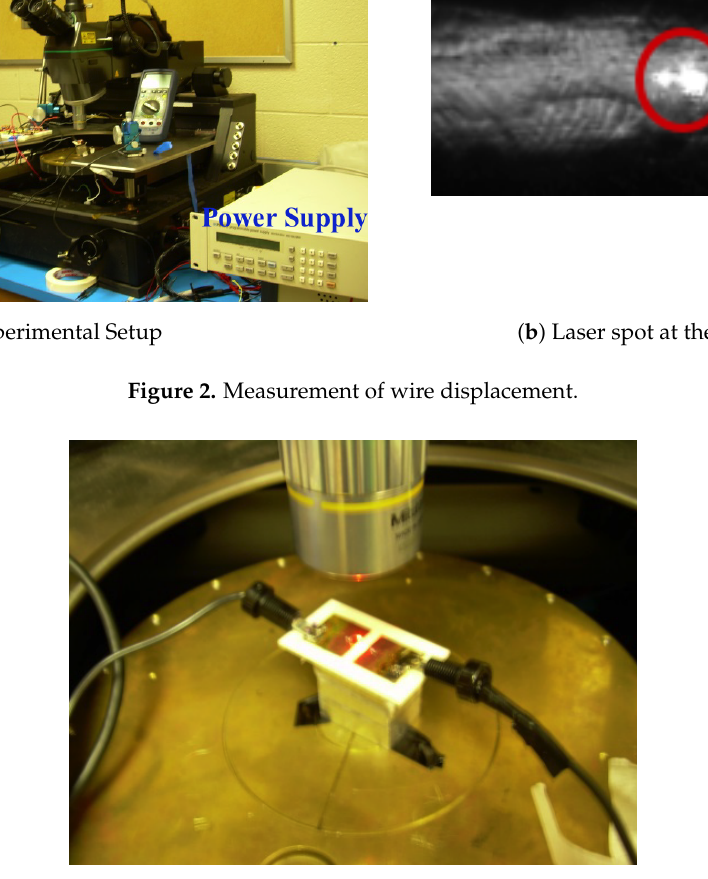
Figure 3. Wire sample under